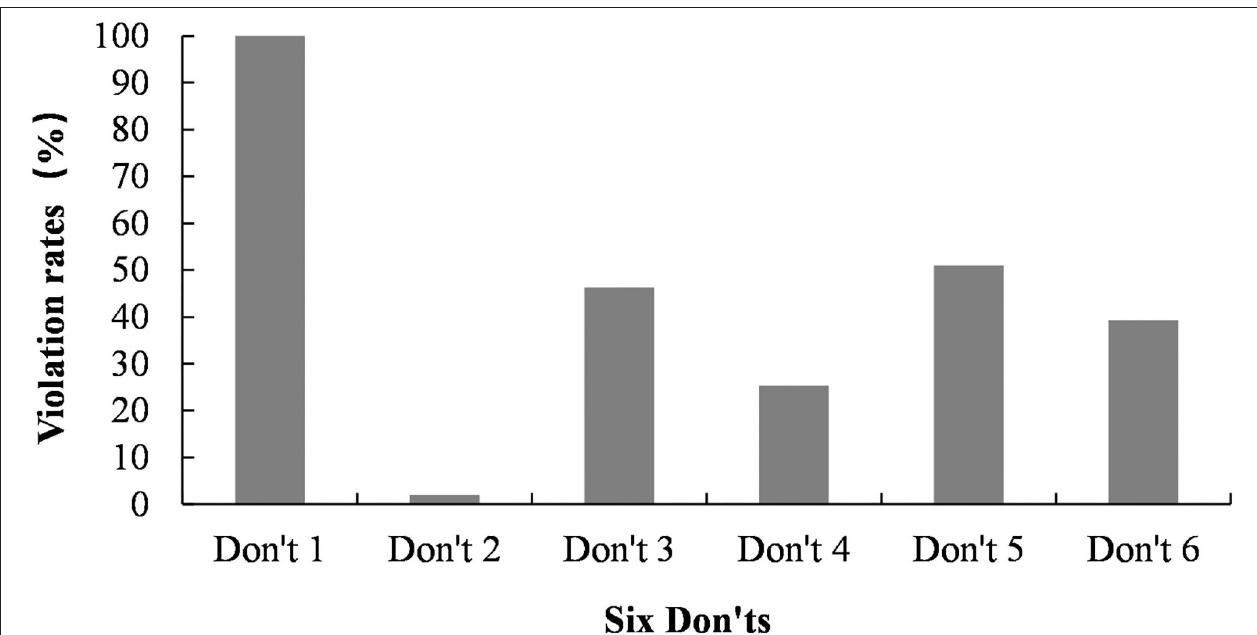
FIGURE 2 | Violation of the WHO recommended list of suicide reporting on Weibo (n 2 = 300 Weibo news items). Don’t 1: Avoid prominent placement and unique repetition of stories about suicide; Don’t 2: Avoid language which sensationalizes or normalizes suicide, or presents it as a solution to problems; Don’t 3: Avoid explicit description of the method used in a completed or attempted suicide; Don’t 4: Avoid providing detailed information about the site of a completed or attempted suicide; Don’t 5: Avoid sensational headlines; Don’t 6: Avoid using photographs, unedited video footage, or links to electronic